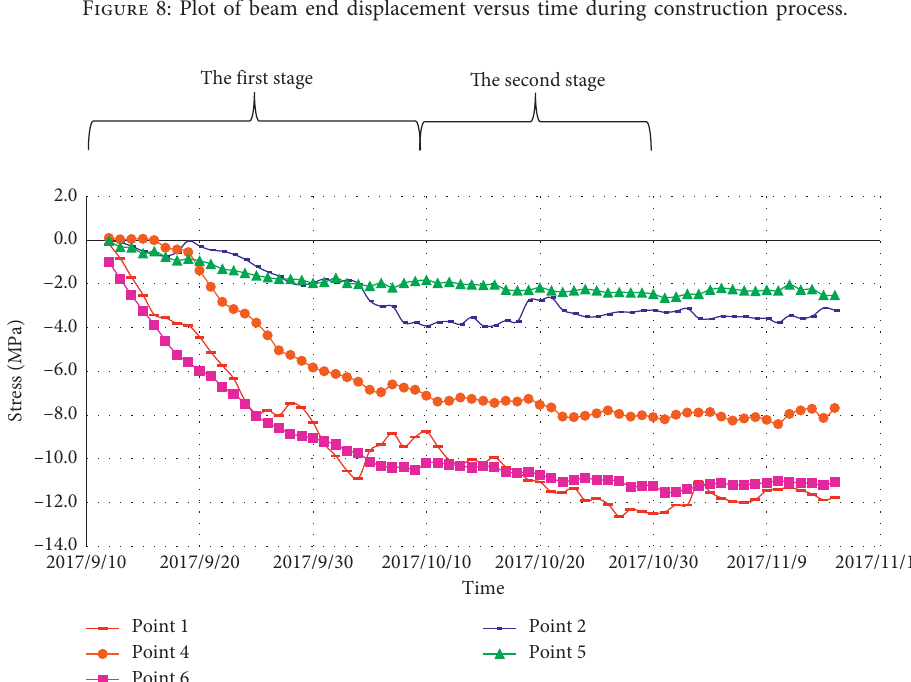
Figure 9: Plot of stress versus time of the eastern column during construction